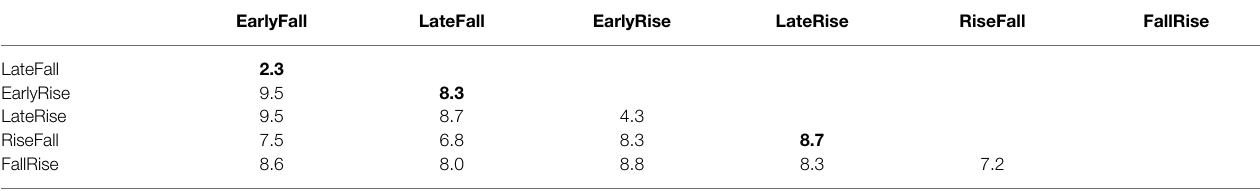
TABLE 1 | Mean subjective phonetic distances per pair of pitch shapes.